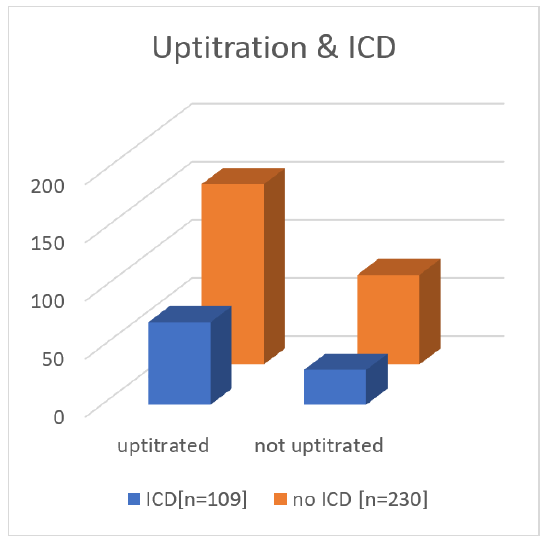
Figure 4. Number of ICD implantations after uptitration and without uptitration (uptitration = any increase in medication dosage). ICD = Implantable cardioverter defibrilator